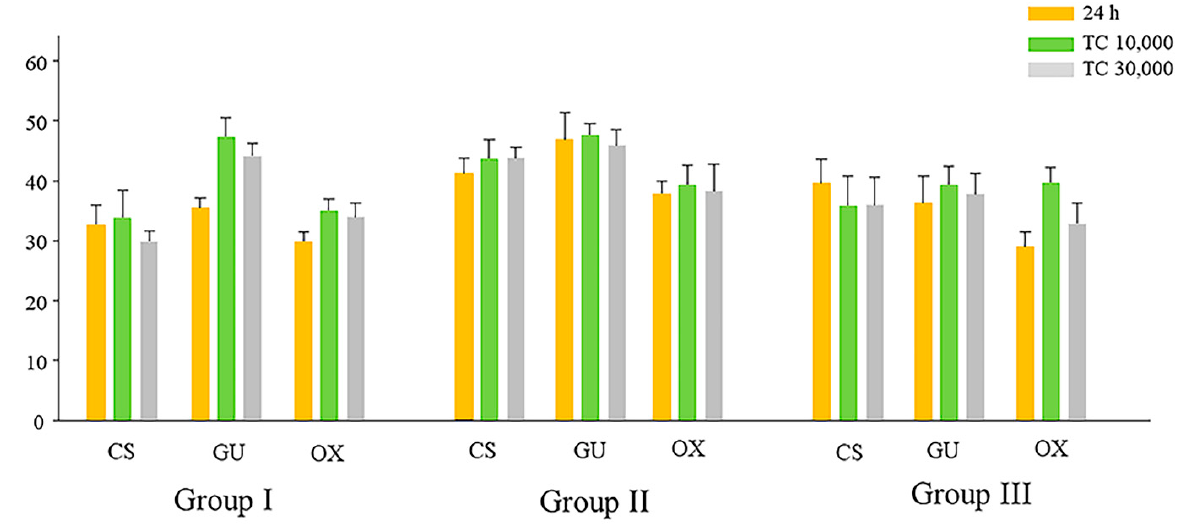
Figure 2. Influence of application method on enamel SBS (SE mode)